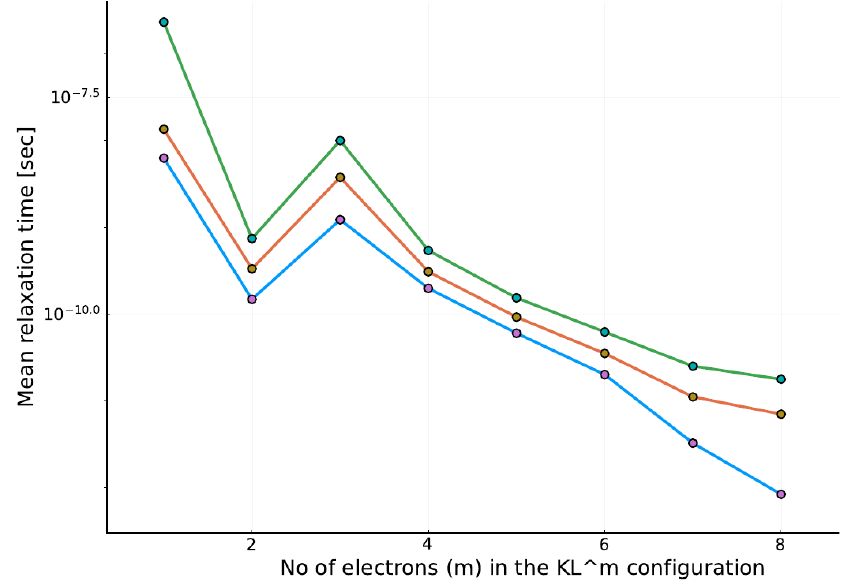
Figure 6. Mean relaxation time of Ar q + ( q = 9 . . . 16 ) ions in initial KL m configurations for returning back to their Z 1 electron ground configurations with a 1 s 2 filled K shell. The L- q and Z q − − − shell electrons are assumed to be distributed statistically among the 2 s and 2 p subshells, and both the radiative decay and autoionization of the ions are taken into account. The mean relaxation times are compared for the stabilization of 70% (blue line), 80% (orange line) and 90% (green line). Here, the thin colored lines are just shown to guide the